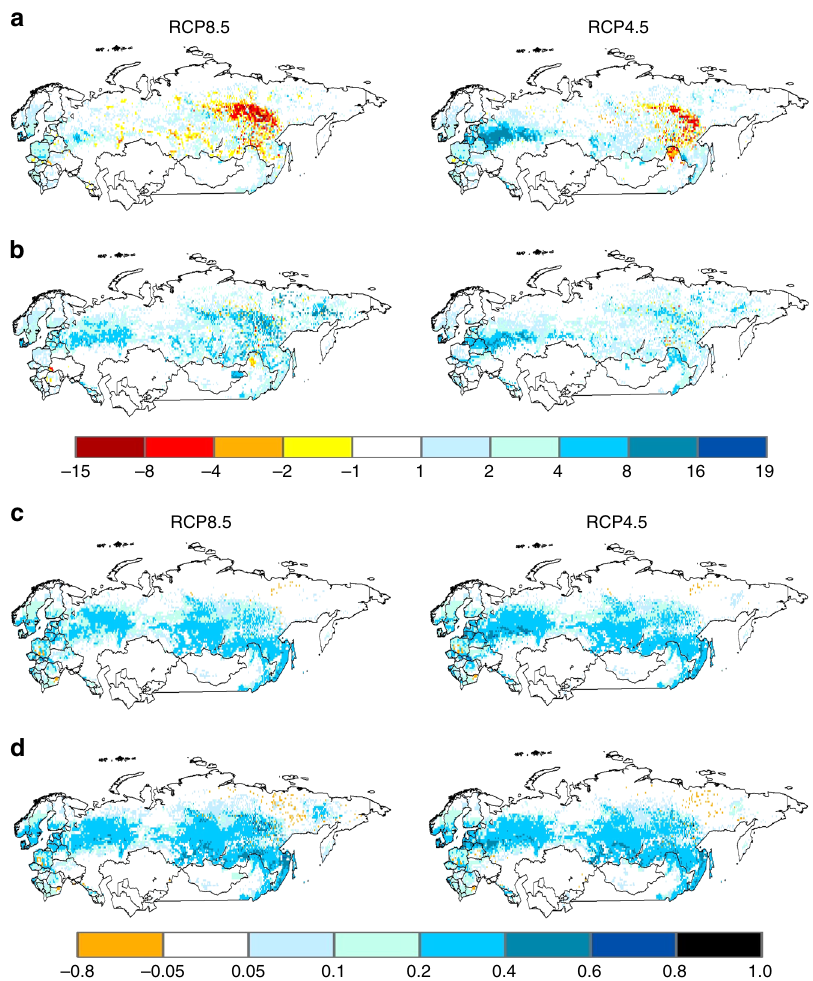
Fig. 8 Changes in the pattern of net C sequestration (kg C m − 2 ) and net N mineralization (kg N m − 2 ) in forests across Northern Eurasia during the 21st century under the RCP8.5 and RCP4.5 global change scenarios. a Net C sequestration represented by cumulative net ecosystem carbon balance (NECB) during the fi rst half of the century (2001 – 2050) b Same as a , but for the second half of the century (2051 – 2100). c Cumulative net N mineralization during the fi rst half of the century (2001 – 2050). d Same as c , but for the second half of the century (2051 –